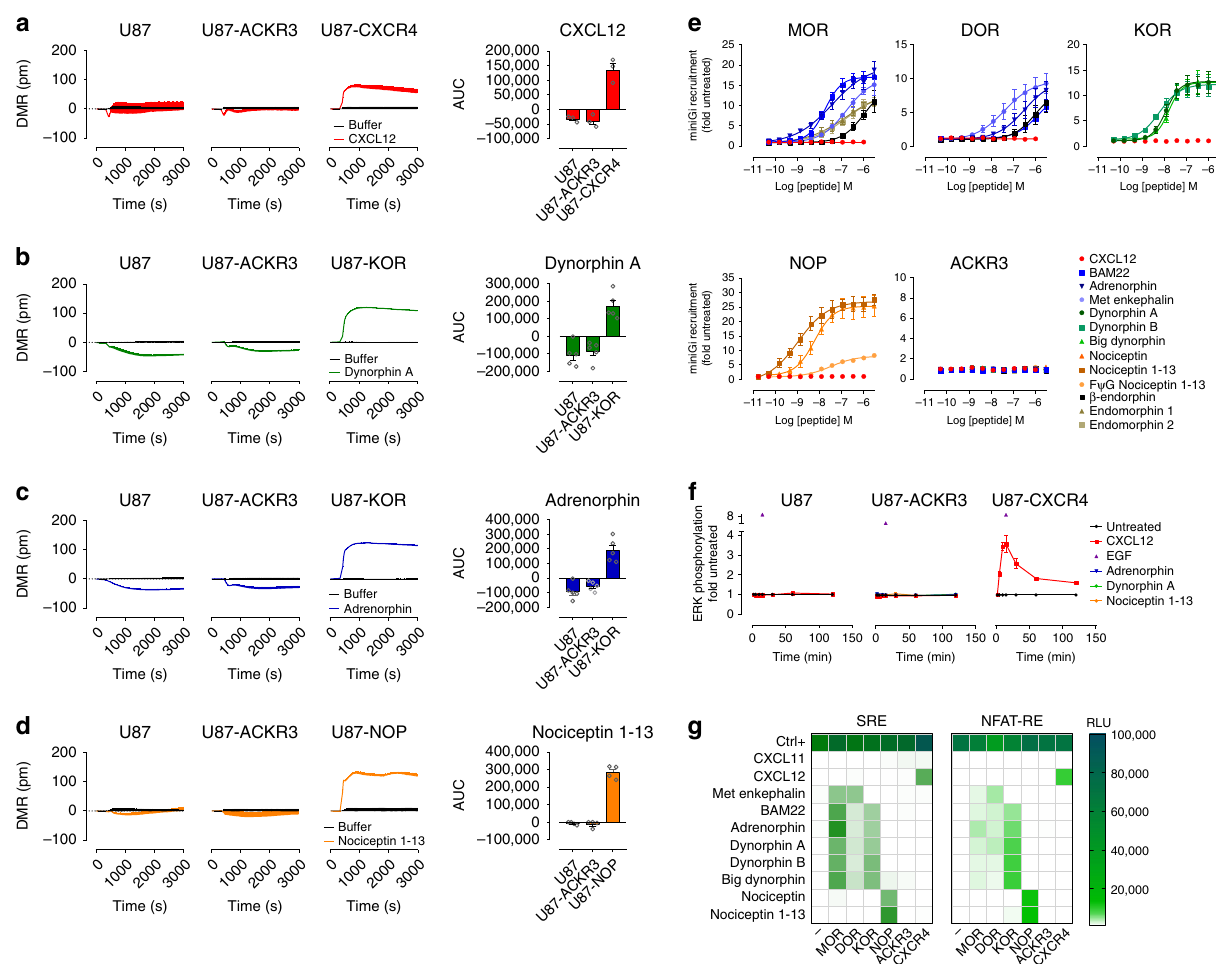
Fig. 5 Absence of ACKR3 signaling in response to opioid and chemokine ligands. a – d DMR pro fi les of U87 cells expressing (or not) ACKR3, CXCR4 or classical opioid receptors (KOR and NOP) stimulated by the chemokine CXCL12 (200 nM) ( a ) or opioid peptides (500 nM) dynorphin A ( b ), adrenorphin ( c ) and nociceptin 1 – 13 ( d ). Left panels: representative DMR pro fi les determined over 3000 s of three to fi ve independent experiments. Right panel: area under the curve (AUC) ± S.E.M. of three to fi ve independent experiments ( n = 3 to 5). e Comparison of mini Gi recruitment to ACKR3 and classical opioid receptors (MOR, DOR, KOR, or NOP) in response to CXCL12 and opioid peptides monitored in U87 cells. The corresponding EC 50 and Emax values are summarized in Supplementary Table 7. f Kinetic analysis of ERK1/2 phosphorylation in U87 cells stably expressing ACKR3 or CXCR4 stimulated by CXCL12 and opioid peptides. EGF was used as positive control. g Comparison of activation of SRE (ERK1/2) and NFAT-RE (Ca 2 + ) signaling cascades (green color scale, relative light units, RLU) in U87 cells (-) or U87 expressing ACKR3, CXCR4 or classical opioid receptors (MOR, DOR, KOR, or NOP) in response to chemokines CXCL12 and CXCL11 (200 nM), opioid peptides (500 nM) or positive controls (30 nM PMA, 10% FBS for SRE and 30 nM PMA, 1 μ M ionomycin, 10% FBS for NFAT-RE). Results represent the mean ± S.E.M. ( e – f ) or the mean ( g ) of three to fi ve independent experiments ( n = 3 – 5). Source data are provided as a Source Data fi did not lead to signi fi cant inhibition of neuronal fi ring, further (Fig. 7e) without activating the ERK signaling pathway (Fig. 7f). con fi rming the inability of ACKR3 to trigger classical G protein In line with U87 cell results, this uptake was also associated with a signaling in this region of the CNS (Fig. 7h). Interestingly, decrease of the extracellular dynorphin A concentration and pretreatment of locus coeruleus neurons with LIH383 (1 or 3 µM) consequently its ability to signal through its corresponding to selectively block the scavenging capacity of ACKR3 resulted in an classical opioid receptor (Fig. 7g). improved potency of dynorphin A towards its classical receptors To ultimately con fi rm the scavenging function of ACKR3 for (Fig. 7i). This observation is in line with our in vitro data and opioid peptides, we monitored ex vivo the inhibition of spontaneous suggests that, in a physiological environment and at endogenous neuronal fi ring in slices of rat locus coeruleus, one of the brain receptor abundance, ACKR3 exerts a scavenging function to regions where ACKR3 is found together with KOR and MOR regulate opioid peptide availability and thereby fi ne tune the (Fig. 7b) 54 . Treatment with dynorphin A led to a concentration- dependent inhibition of fi ring with total inhibition obtained with signaling through their classical opioid receptors. 1 µM (Fig. 7h). However, the same concentration of dynorphin A did not lead to a change in neuronal fi ring rate when pretreated Discussion with naloxone, indicating that the dynorphin A-induced inhibition of the fi ring can be attributed to a classical opioid receptor. More than 40 years after the identi fi cation of the classical opioid Treatment with LIH383 at concentration as high as 3 µM however receptors MOR, DOR and KOR and 20 years after the